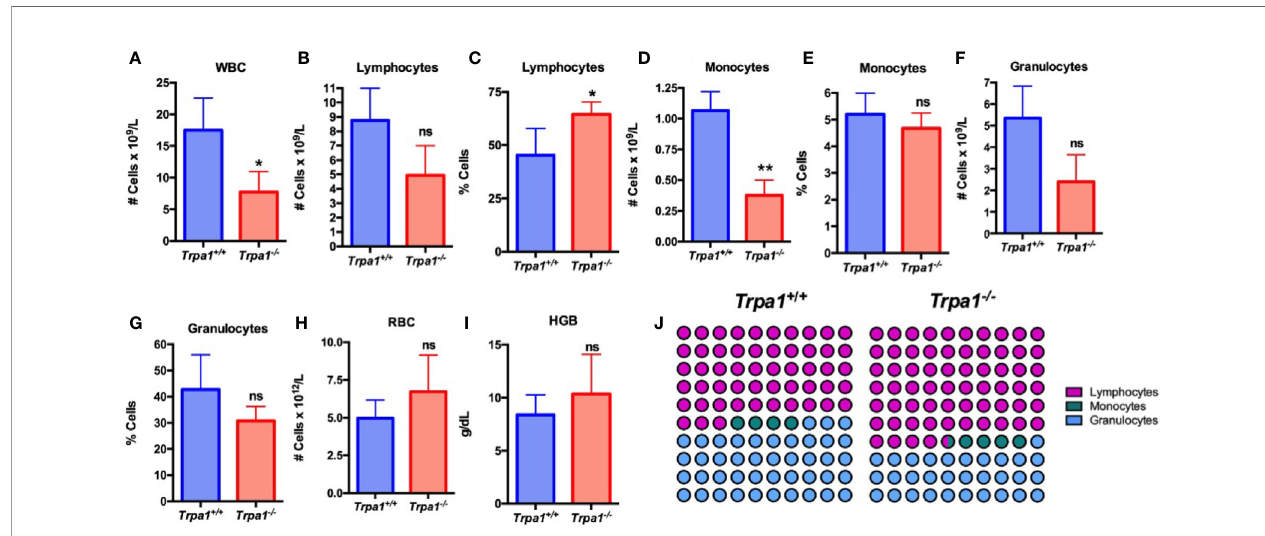
FIGURE 2 | Blood analysis of Trpa1 +/+ or Trpa1 -/- mice on the 22 nd day after B16-F10 cell inoculation. (A) White blood cells; (B, C) Absolute number and percentage of lymphocytes; (D, E) Absolute number and percentage of monocytes; (F, G) Absolute number and percentage of granulocytes; (H) Red blood cells; (I) Hemoglobin; (J) Representative percentage of lymphocytes, granulocytes, and monocytes. Values are shown as mean (n = 3 for Trpa1 +/+ and n=4 for Trpa1 -/- ) ± SD. *p < 0.05; **p < 0.01; ns, not signi fi cant. Statistical analyses were performed by Student ’ s t -test between the